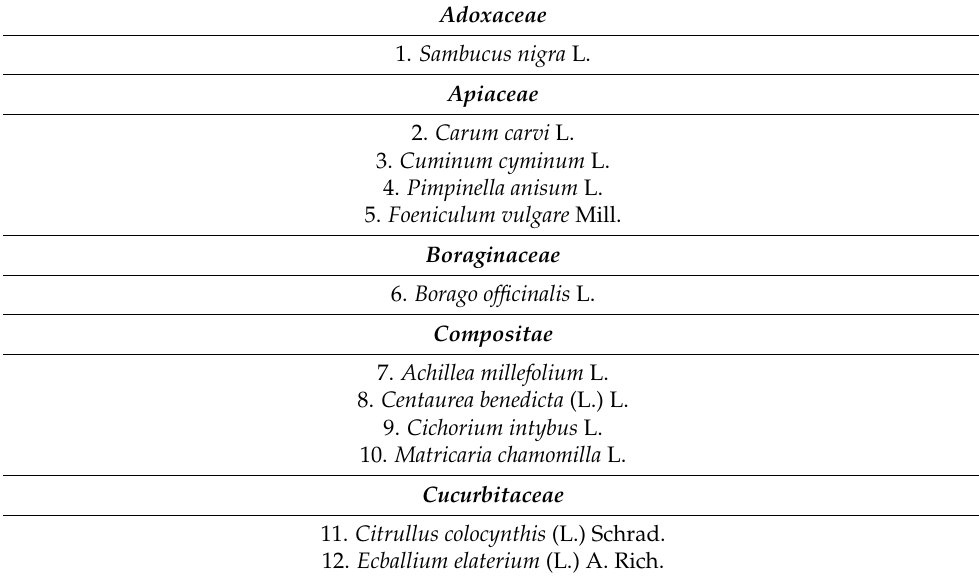
Table 3. List of species selected for the restoration project of the ancient Hortus simplicium